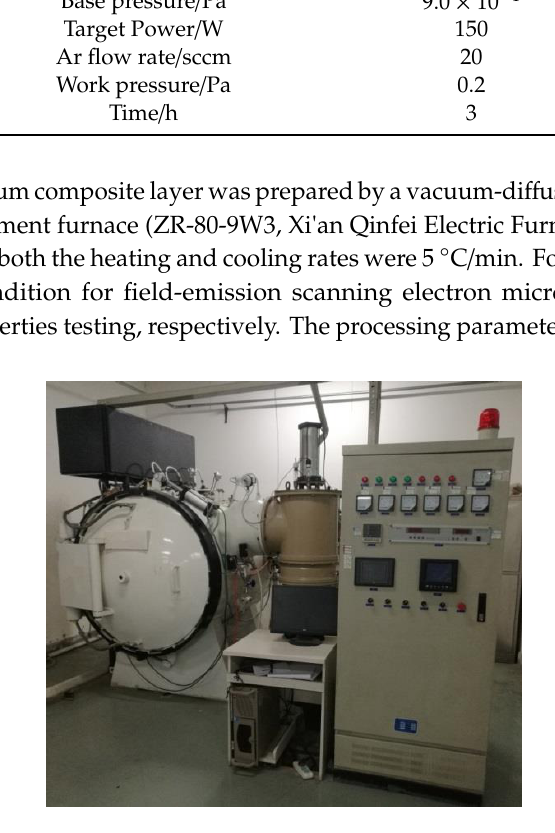
Figure 3. Vacuum heat treatment furnace. Table 3 . Processing parameters of the vacuum-diffusional annealing treatment.